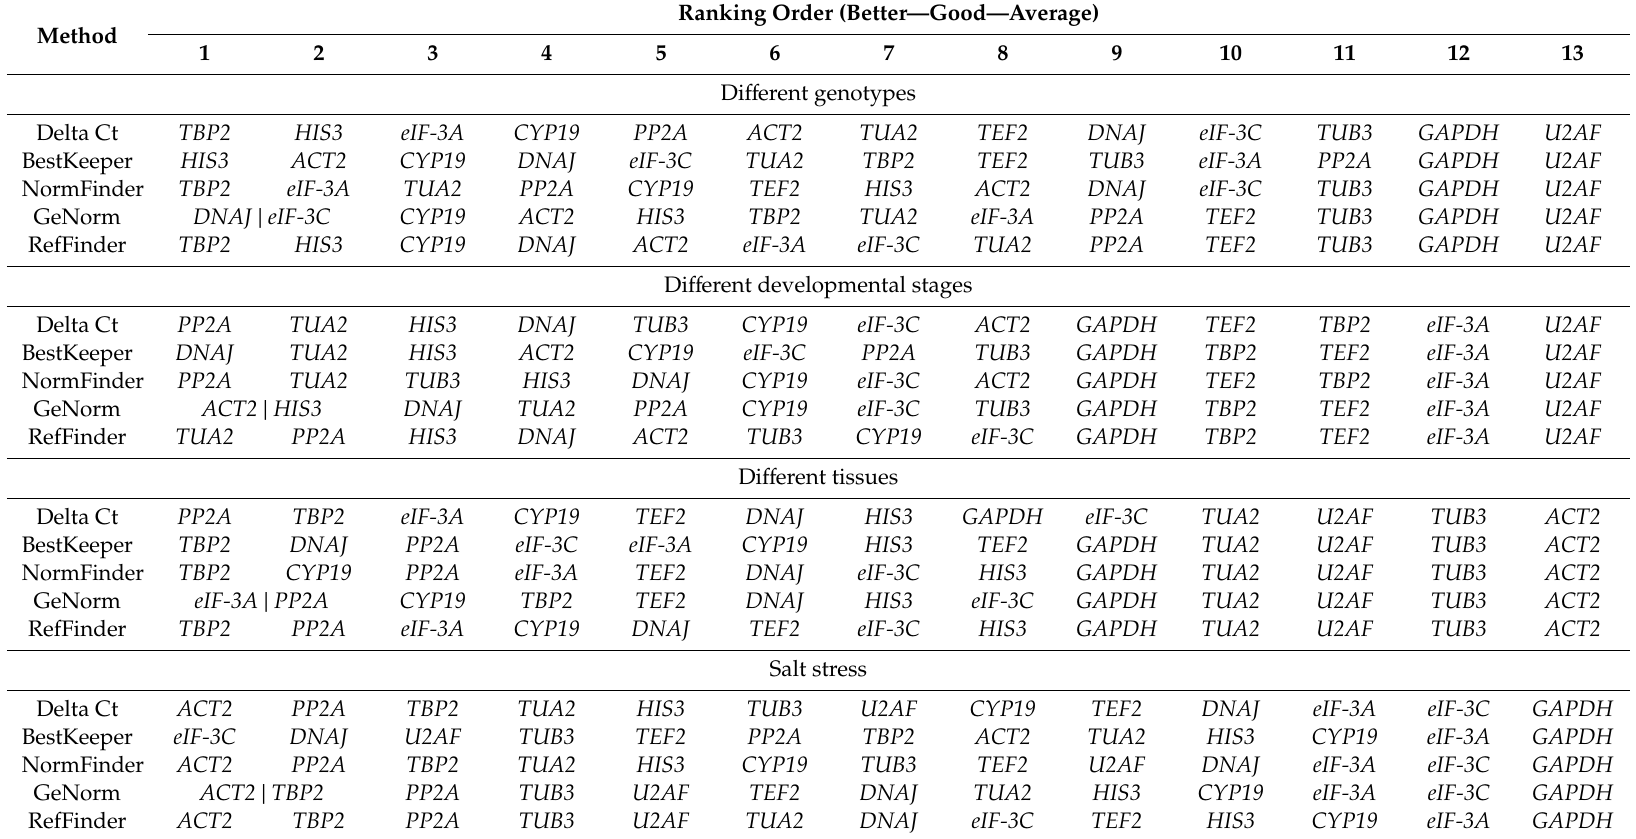
Table 4. Stability ranking of 13 candidate reference genes calculated by Delta Ct, BestKeeper, NormFinder, GeNorm, and